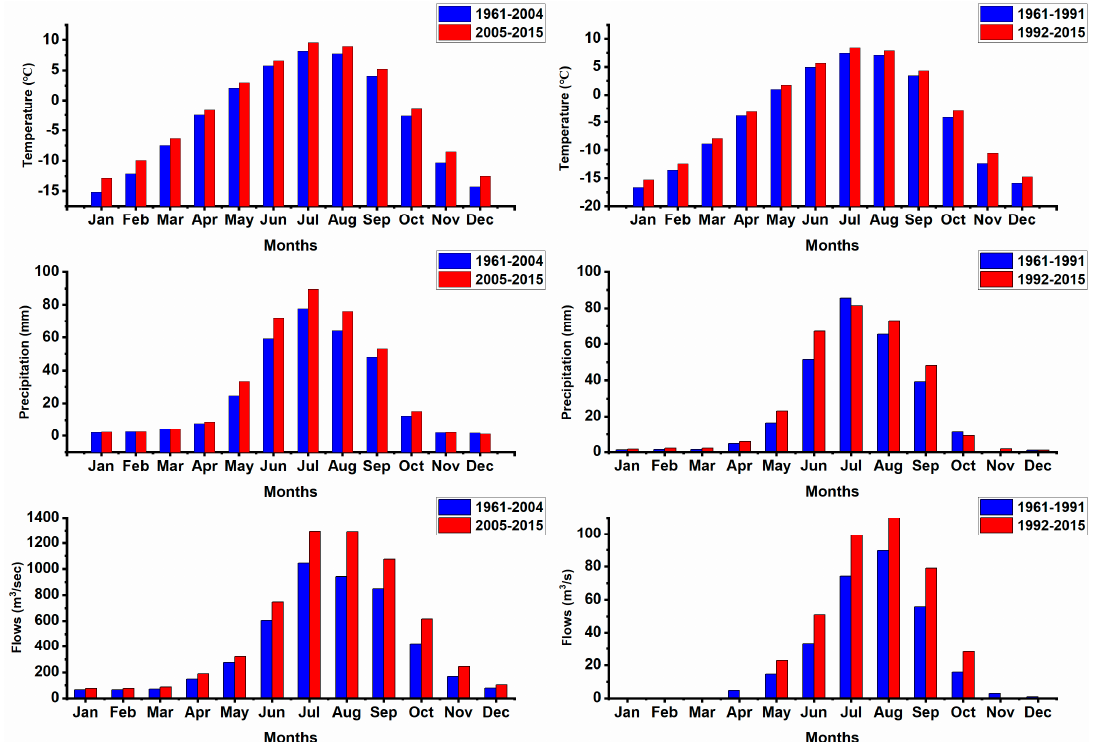
Figure 6. Change of monthly temperature, precipitation and flows for the Zhimenda ( left column ) and Tuotuohe ( right column ) sub-basins of HWYZ during 1961–2015.